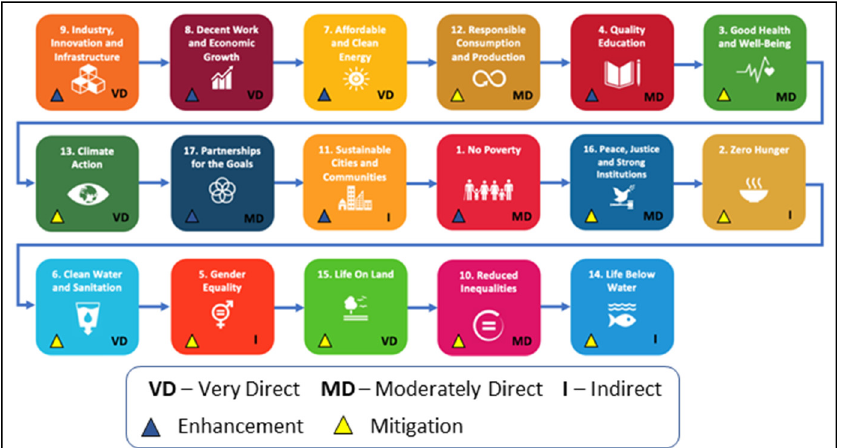
Figure 1. Ranking of the significance of SDGs for the RM sector by the Greek stakeholder groups. The type of RM sector impact on the specific SDGs was codified based on EBRD [18].